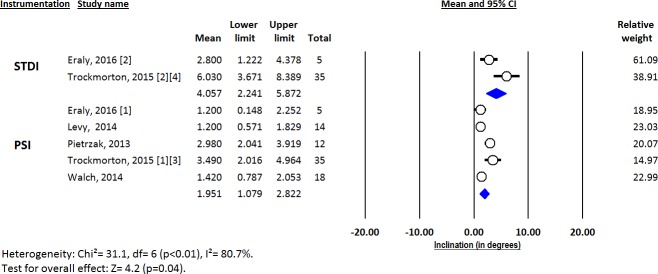
Forest plot of inclination deviation from the pre-operative planning, for cadaveric studies.